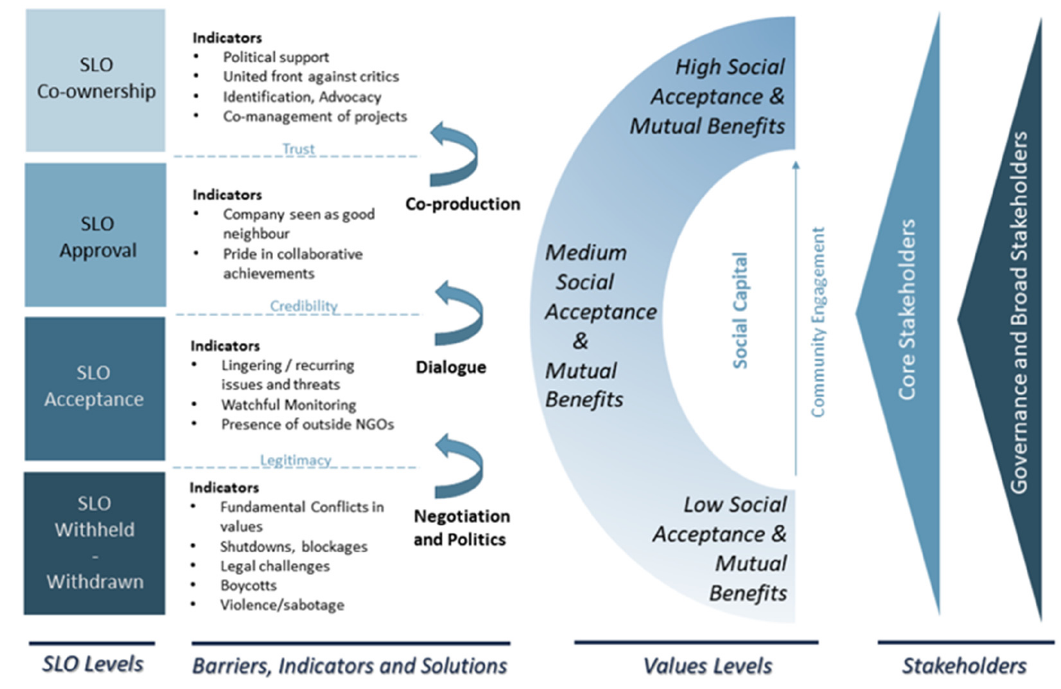
Figure 7. SLO Model for Geothermal Energy [ 33,34 ]